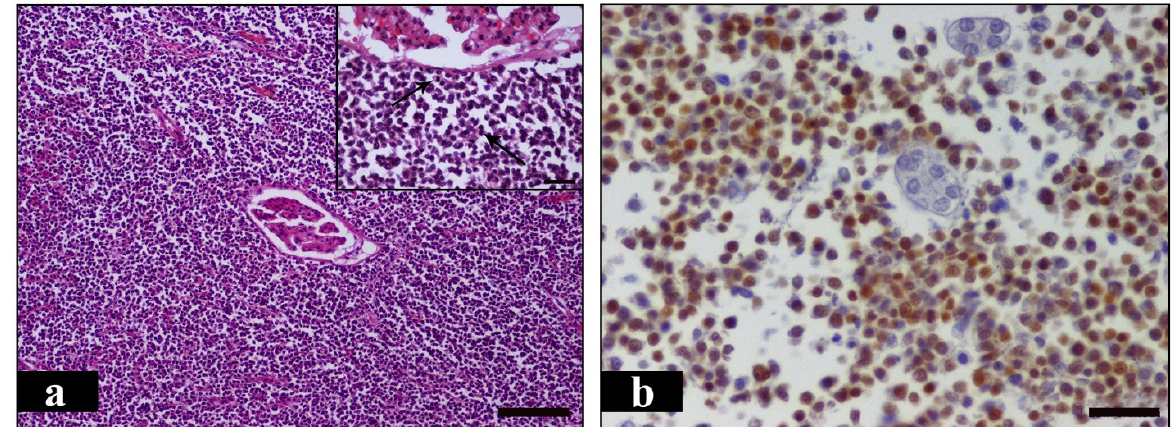
Figure 5. Histologic sections of a renal mass. ( a ). Numerous neoplastic mononuclear cells surround a nephron in the renal cortex. Inset: Tumor cells have round shape, eosinophilic cytoplasm and large nuclei while high mitotic activity is noted (arrows). H&E (Hematoxylin and eosin), bar = 100 µ m, inset bar = 25 µ m. ( b ). Numerous neoplastic B lymphocytes show intense positive nuclear staining for Pax-5. IHC, EnVisionTM detection, bar = 25 µ m.